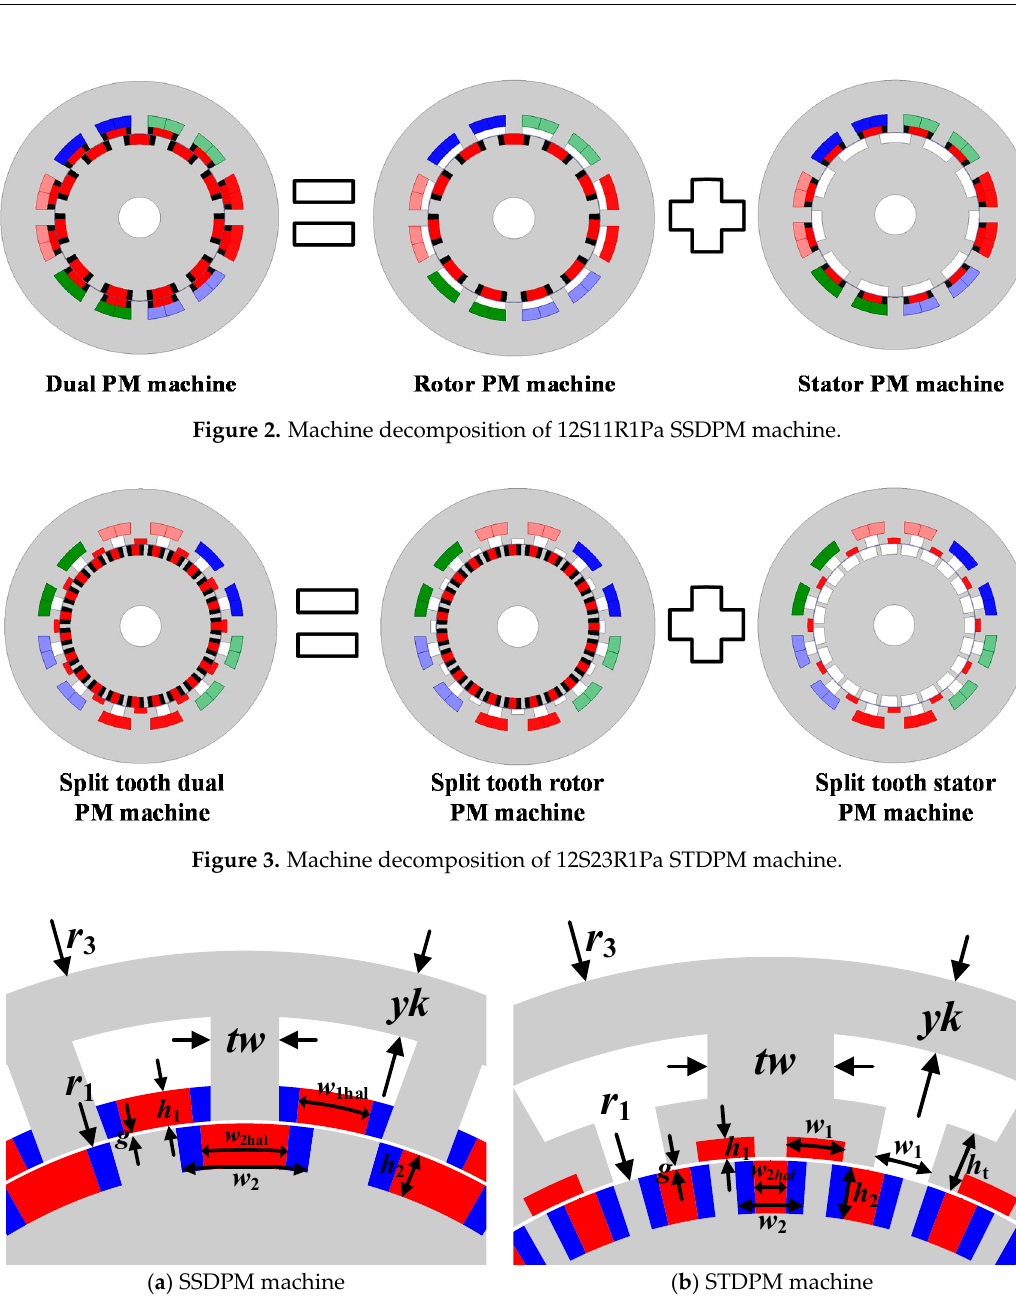
Figure 4. Key design dimensions of dual-PM machines. ( a ) SSDPM machine; ( b ) STDPM machine.